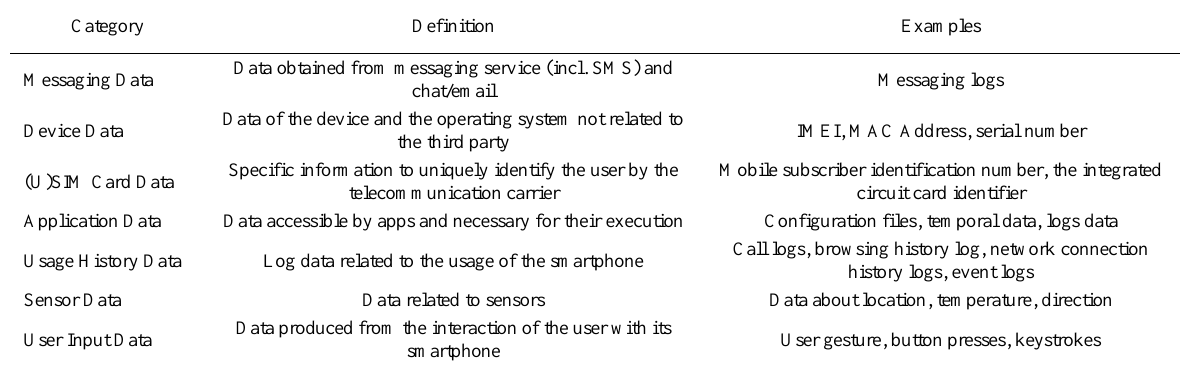
Table 1. Smartphone data taxonomy according to the data sources